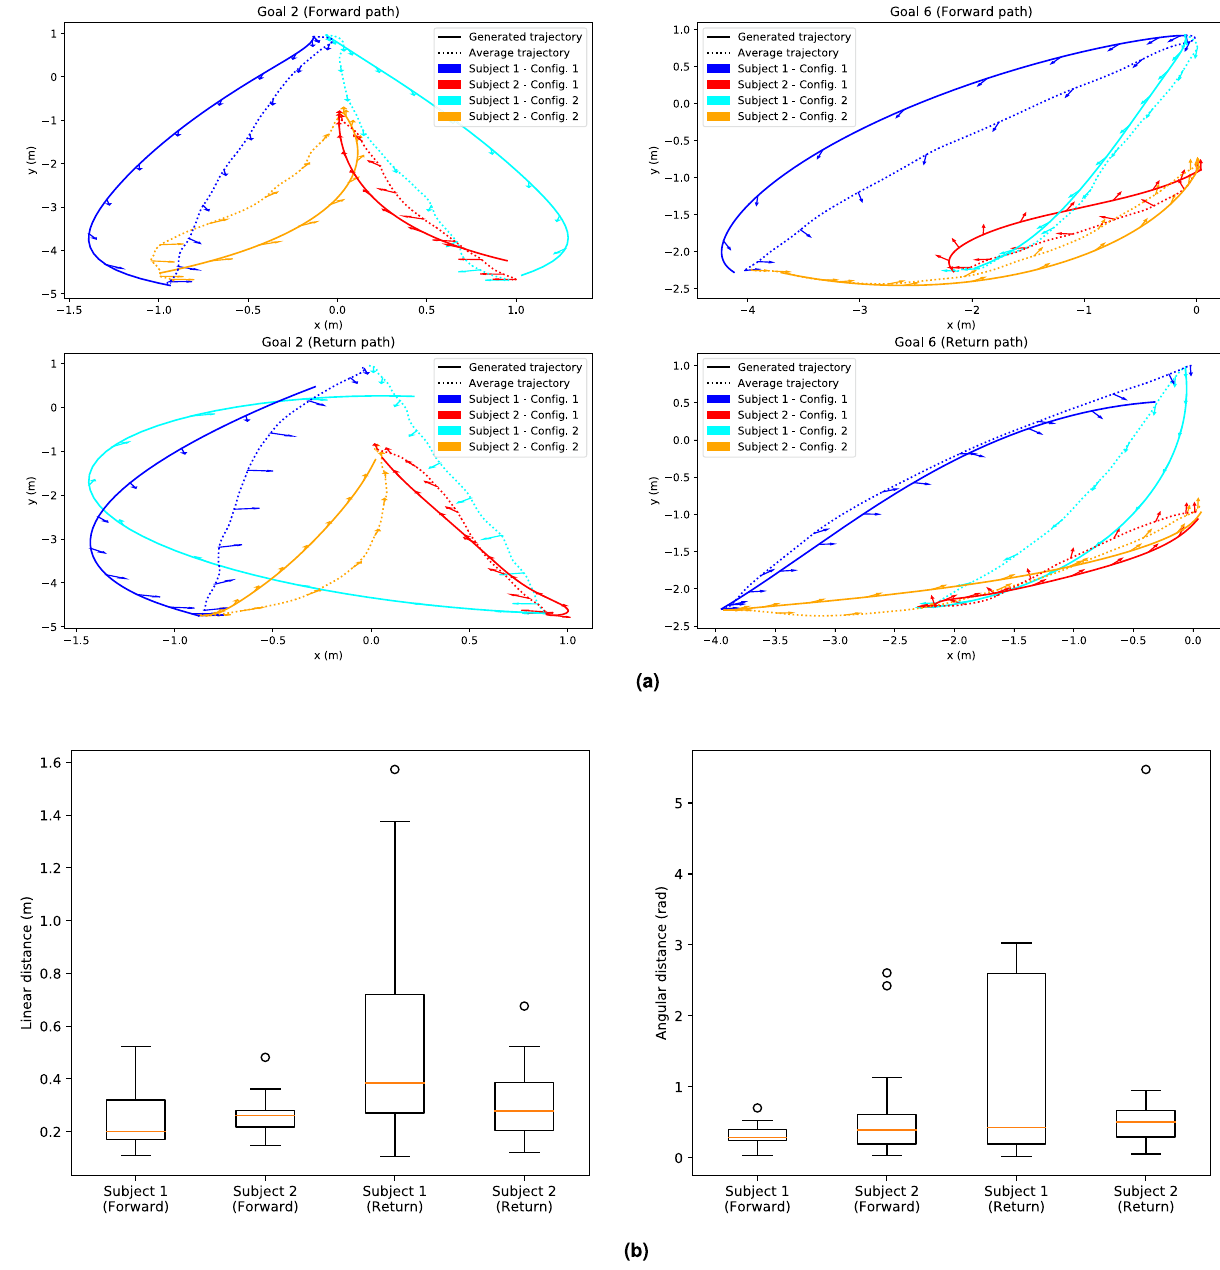
Figure 8. Comparison between the trajectories generated with the coupled OC model and the average measured trajectories. ( a ) Average (dotted line) and generated trajectories (full line) for both subjects, with both configurations when measured. The arrows represent the orientationof the pelvis of the subjects during locomotion. ( b ) Boxplot of the linear (on the left) and angular (on the right) distances between the generated and the average measured trajectories for every goal positionsaccording to both subjects and to the direction of the